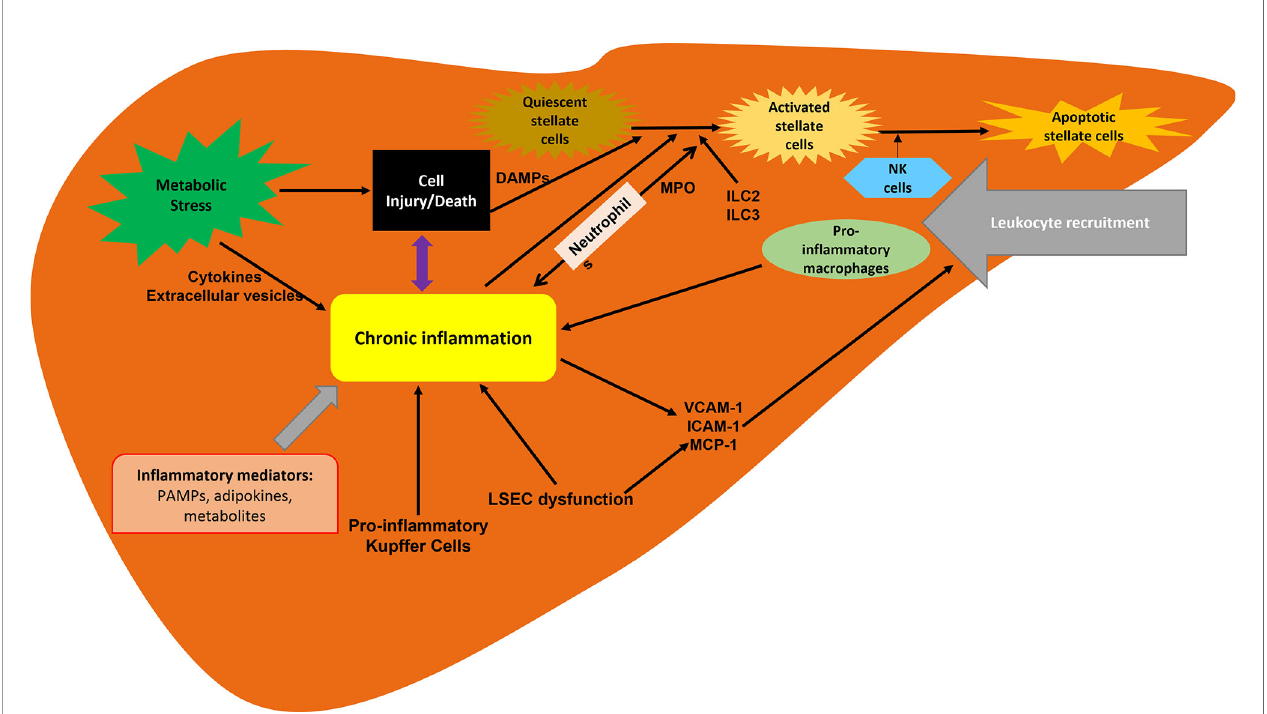
FIGURE 1 | In fl ammation associated with NASH. In fl ammation is driven by the cellular interplay involving hepatocytes, hepatic stellate cells and recruited immune cells. Hepatocyte death and in fl ammatory mediators are key contributors to in fl ammation in NAFLD and NASH progression. ILC, innate lymphoid cells; LSECs, liver sinusoidal endothelial cells; MCP-1, macrophage chemotactic protein 1; MPO,